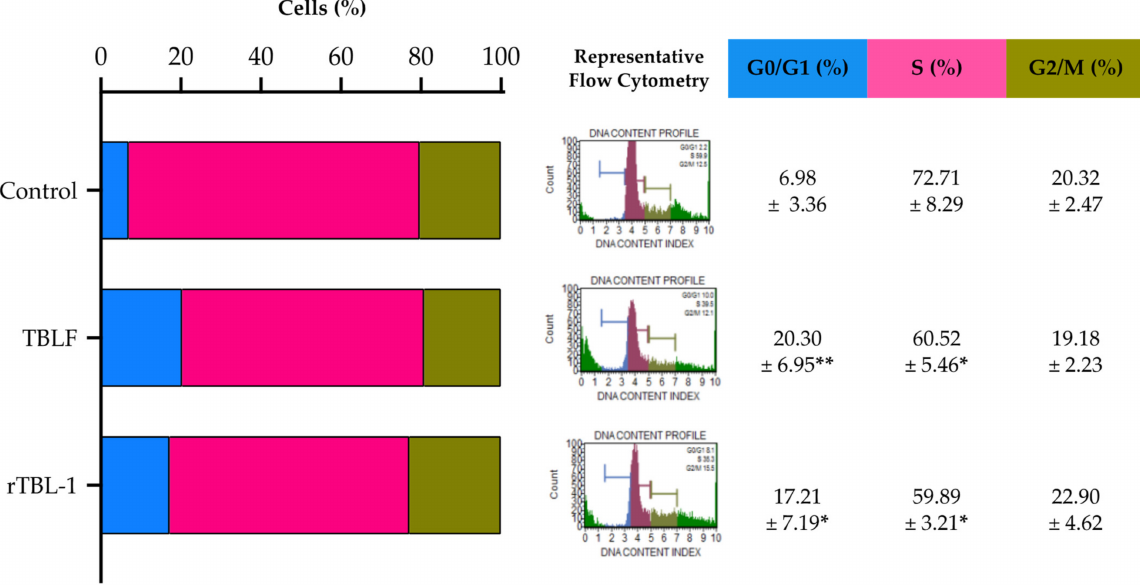
Figure 3. rTBL-1 induced G0/G1 and S cycle cell arrest on HT-29 cells. Cells were treated with TBLF-LC 50 or rTBL-1-LC 50 for 8 h. Graphic representation for cell cycle changes, representative flow cytometry assays, and results of at least three independent experiments shown in percentage. One-way ANOVA was performed for each cell cycle phase. (*) p ≤ 0.05 and (**) p ≤ 0.01 indicates a significant difference (Dunnett) with respect to control